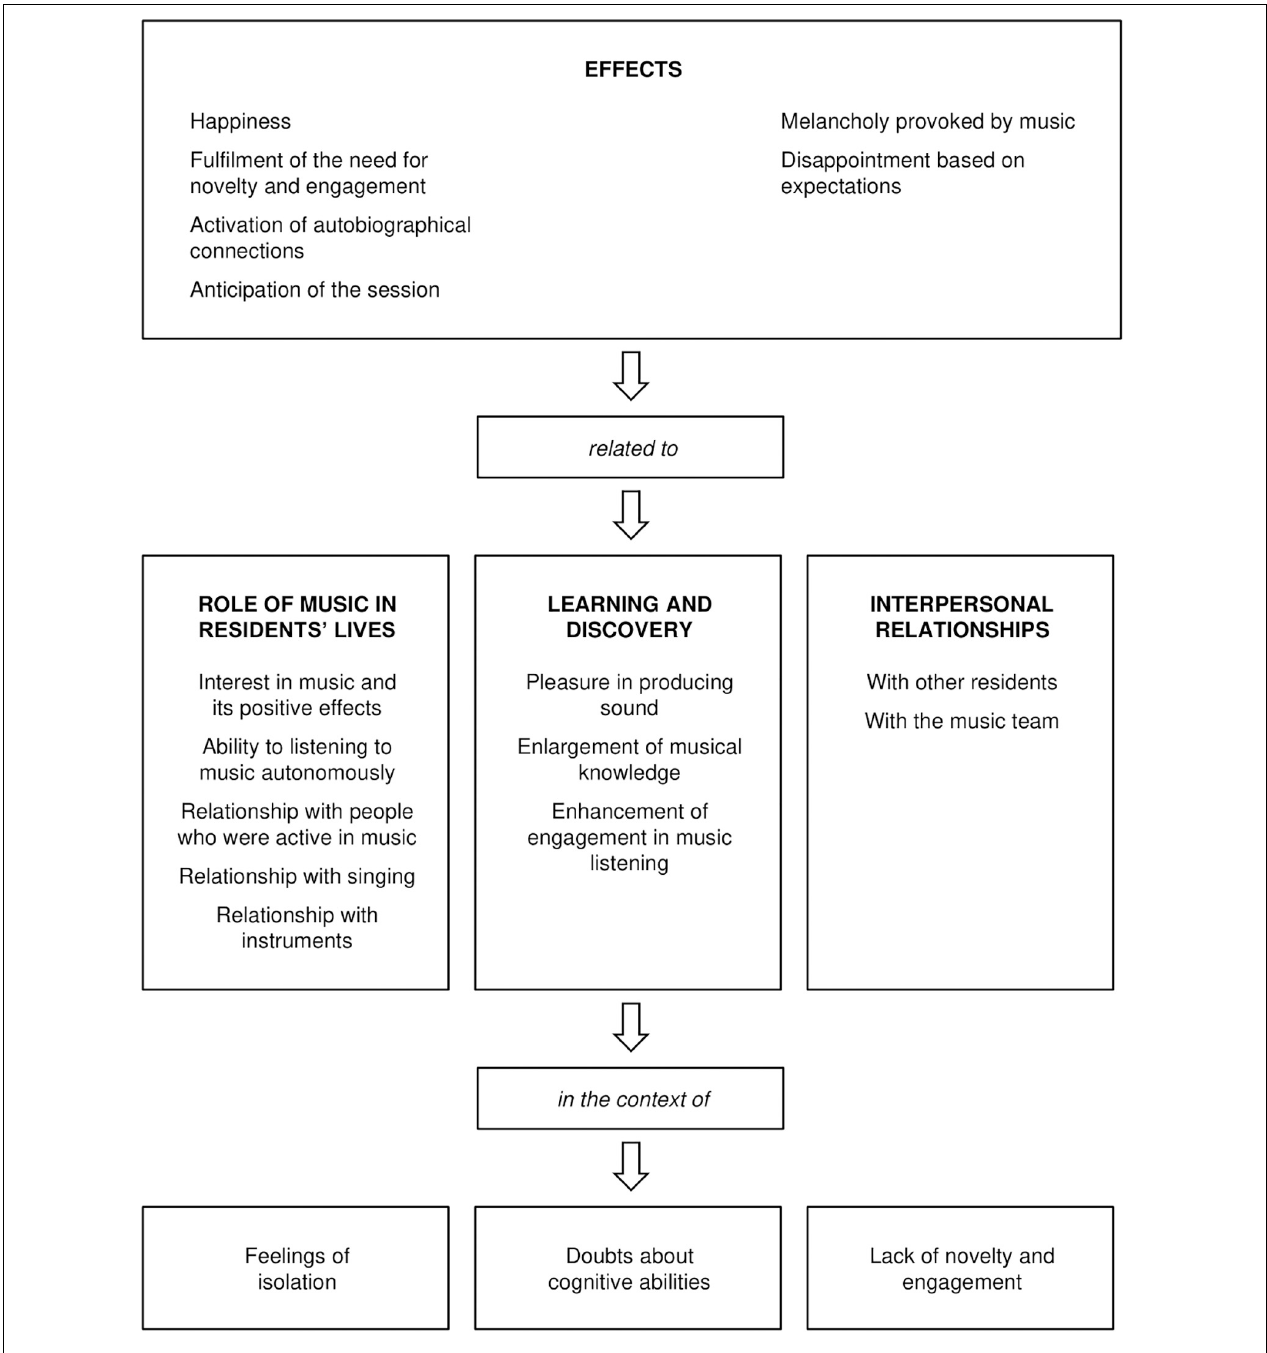
FIGURE 1 | Interactions between themes and subthemes arising from the